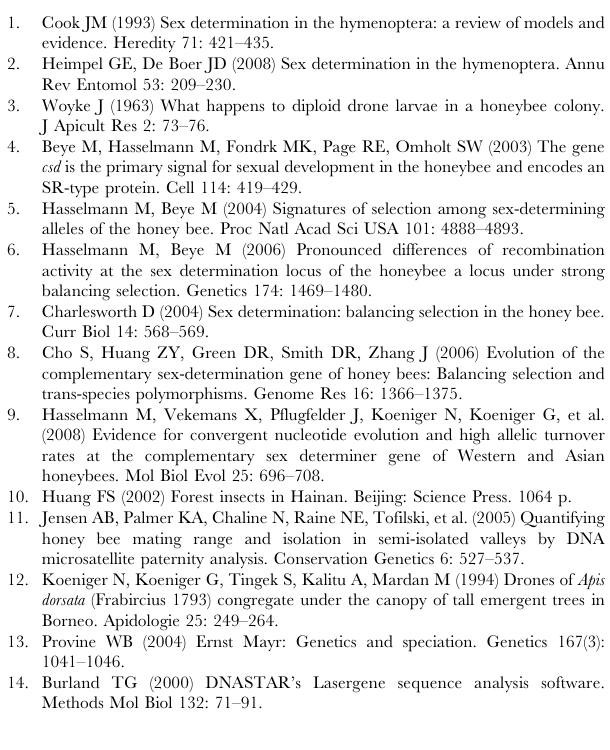
Figure S1 Amino acid sequence alignment of region 3 of the Apis dorsata csd alleles from this research (those started with Adcsd) and those reported by Hasselmann et al. 2008 [ 9 ] (those started with Dors). A total of 54 predicted amino acid sequences were used. Alignment was